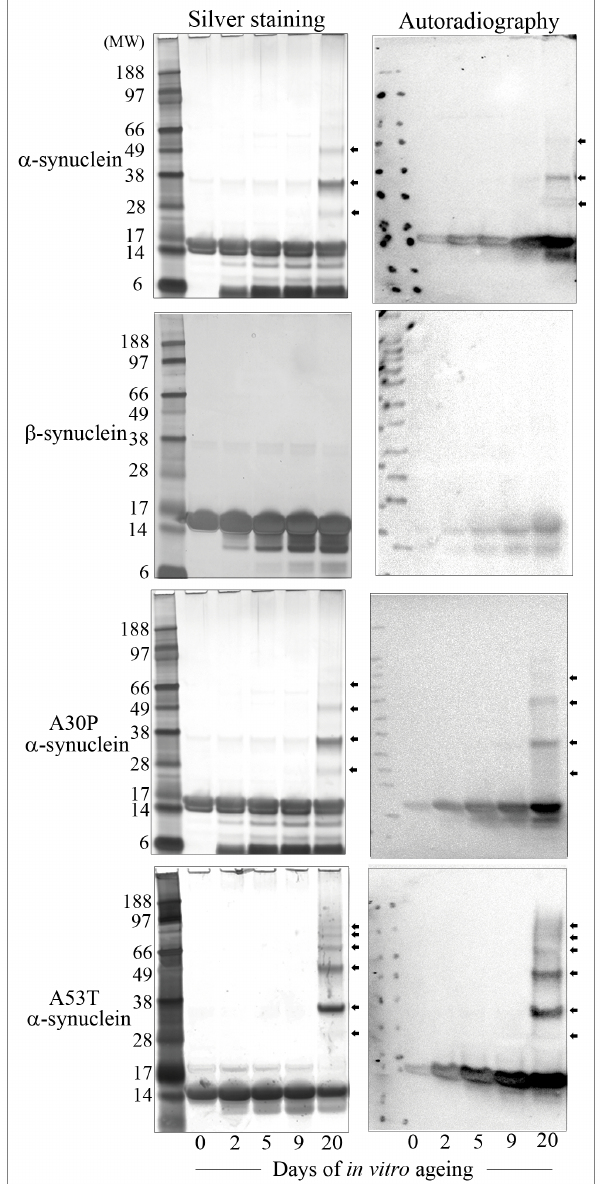
Figure 6. 1D-PAGE resolution of invitro aged and methylated synucleins, and methyl ester autoradiography. Synuclein pro- teins were methylated with 3 H-SAM using exogenous PIMT, resolved by 1D PAGE and proteins stained with silver (left panels), or proteins transferred to PVDF and the level of isoaspartate methylation visualised by autoradiography (right panels). Wild-type and mutant a -synuclein proteins formed stable protein oligomers that contained isoaspartate peptide linkages (marked with arrowheads).